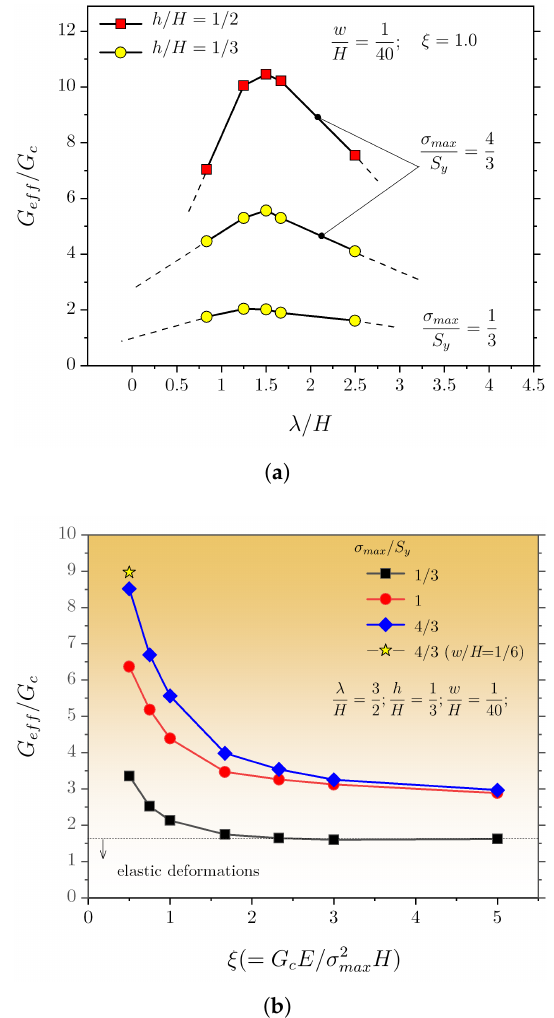
Figure 10. Evolution of the effective dissipated energy as a function of ( a ) λ / H and ( b ) G c E / σ 2 H